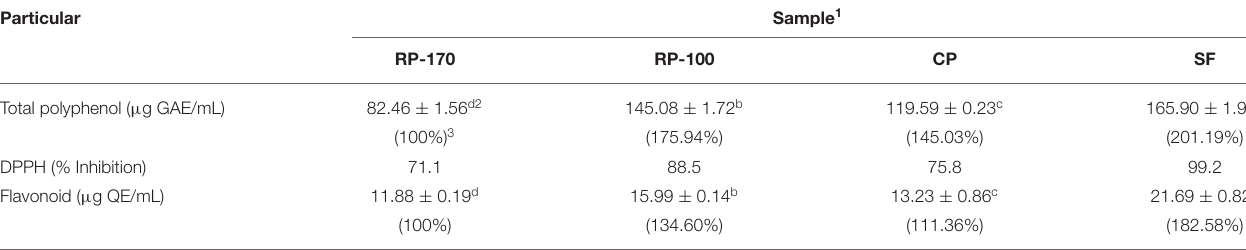
1 Samples are defined in Table 1 . 2 Quoted values are means ± SD of triplicate measurements. Value followed by different superscripts in the same row are significantly different (p < 0.05). 3 Values in parentheses represent the relative percentage of lemon seed oil extracted by the RP-170